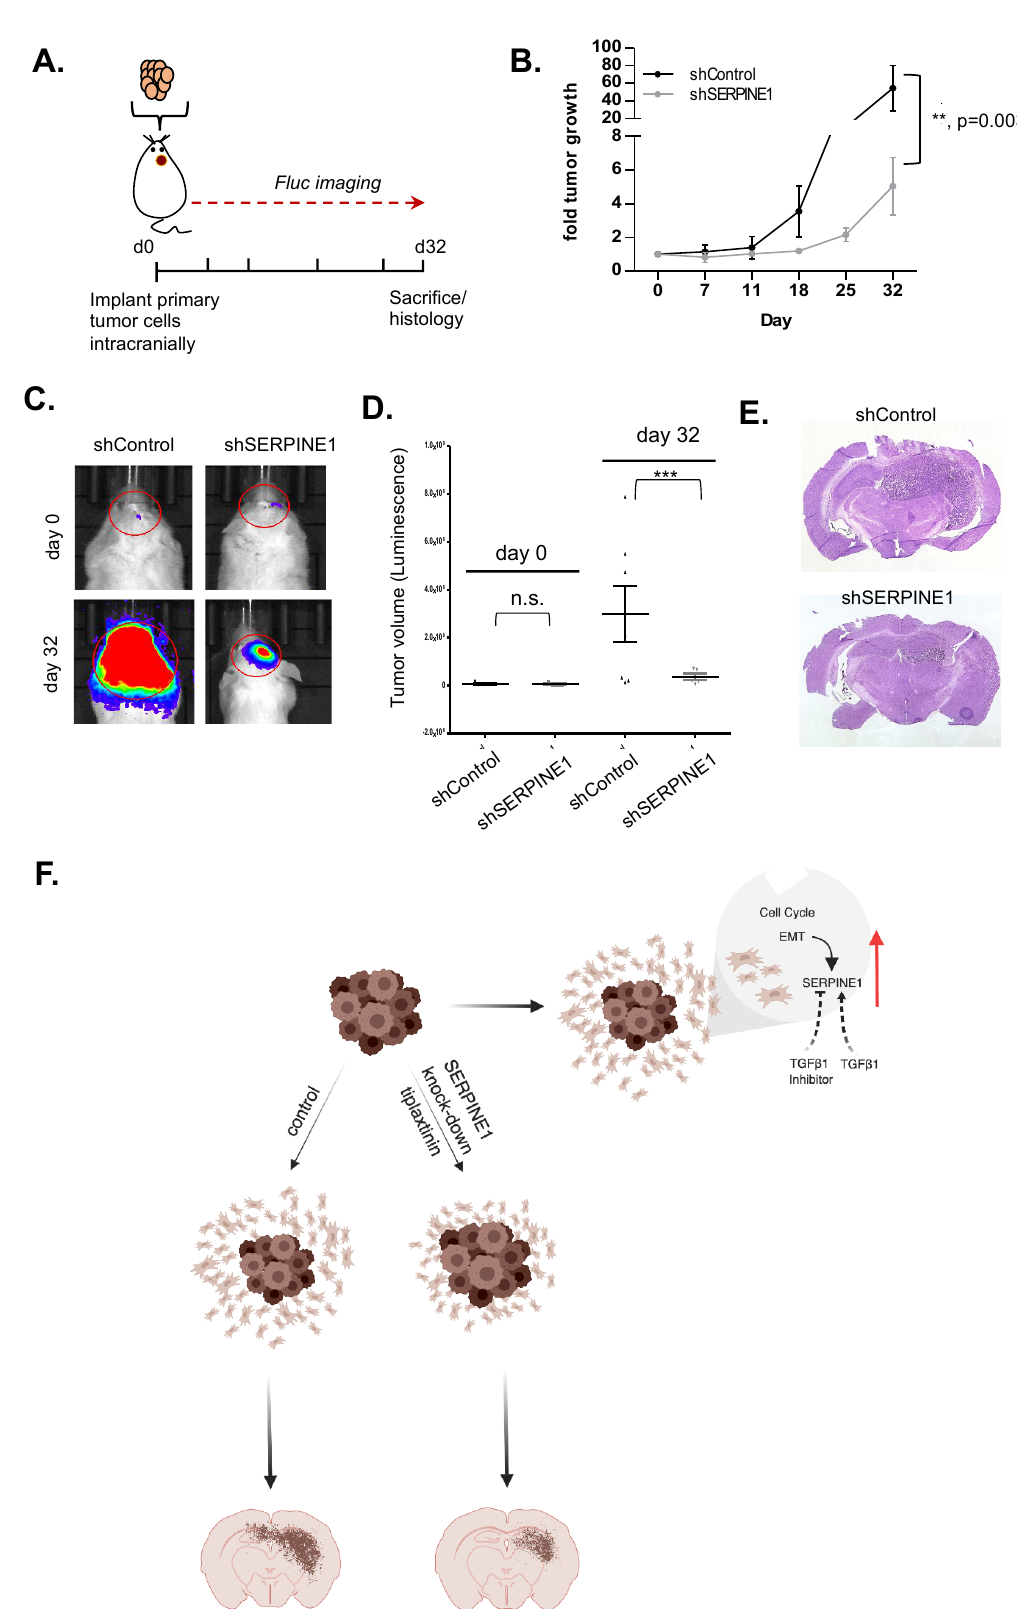
Figure 6. SERPINE1 knock-down reduces tumor progression in vivo. A. Strategy of in vivo experiment. B. Graph showing tumor growth as measured by bioluminescence radiance for 32 days after tumor cell injection. Data were normalized to day 0 signal of each group (n=7 mice for shControl, n=5 mice for shSERPINE1). C. Representative bioluminescence images of tumors from day 0 and 32 displaying normalized bioluminescent efficiencies acquired (blue to red indicates lower to higher radiance as photons/s/cm2/steradian). D. Plot depicting individual tumor volumes on day 0 and day 32. E. Representative H&E images of shControl and shSERPINE1 tumors (magnification is 13.5 X). F. Model describing dynamic regulation of SERPINE1 and mechanism of SERPINE1 knock- down acting on dispersal.Image created with BioRender. (** and *** denote P <0.05, P <0.001 respectively, ANOVA)